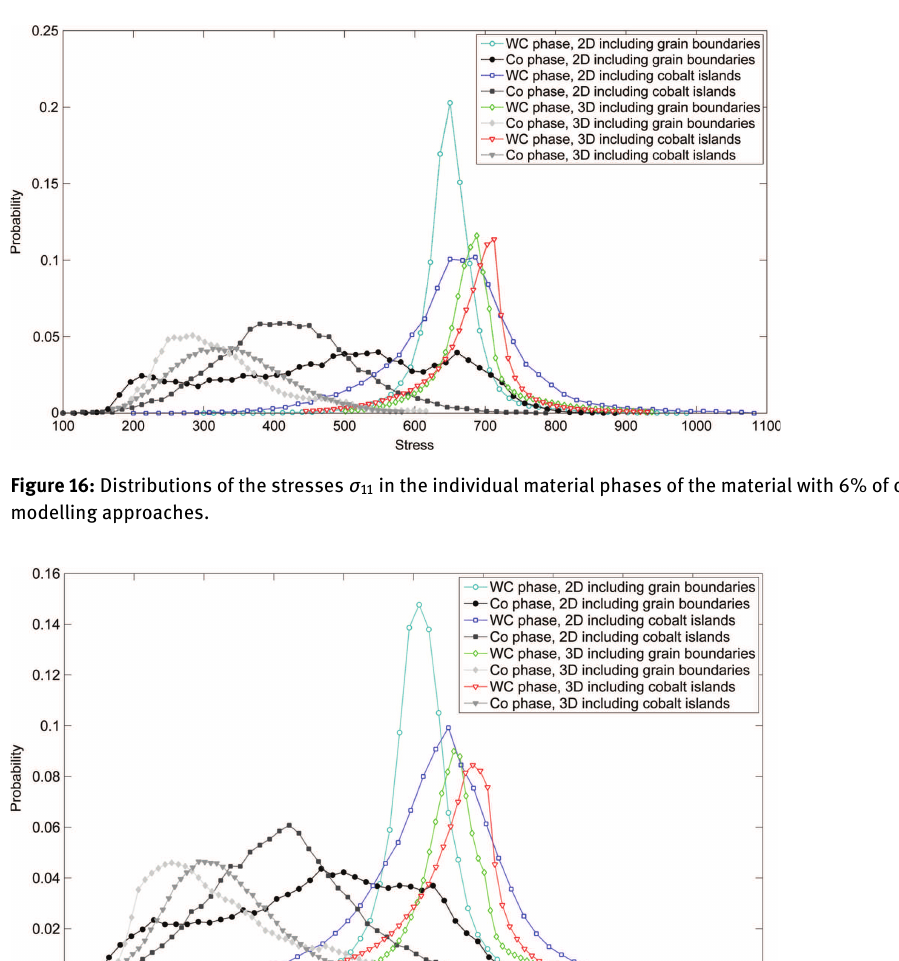
Figure 15: Distributions of the stresses σ 11 in the individual material phases with respect to the cobalt content, 3D model including continuous grain boundaries.